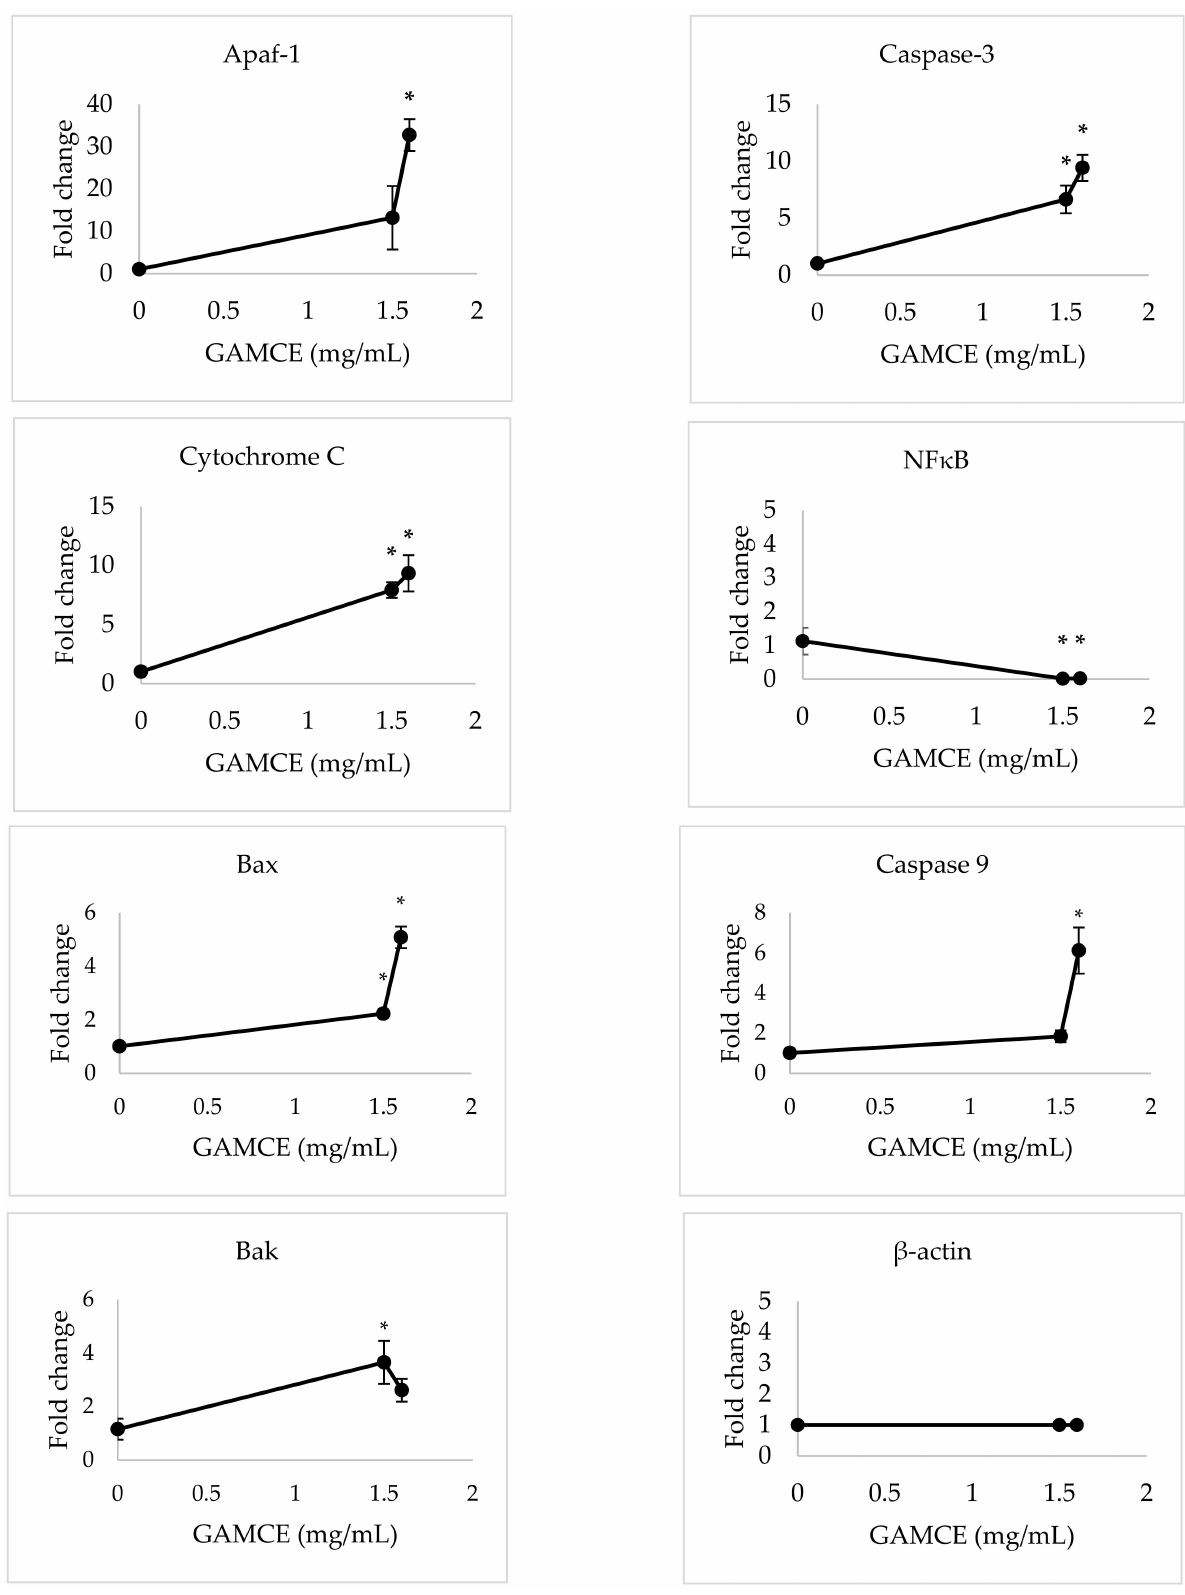
Figure 5. RT-qPCR results of relative gene expressions of GAMCE (1.5 and 1.6 mg/mL) treated HeLa cell lines compared with the control group (0 mg/mL) with no treatment, of 12 h incubation. The data are shown as Mean ± SE. Mean significant difference (* p < 0.05) compared to